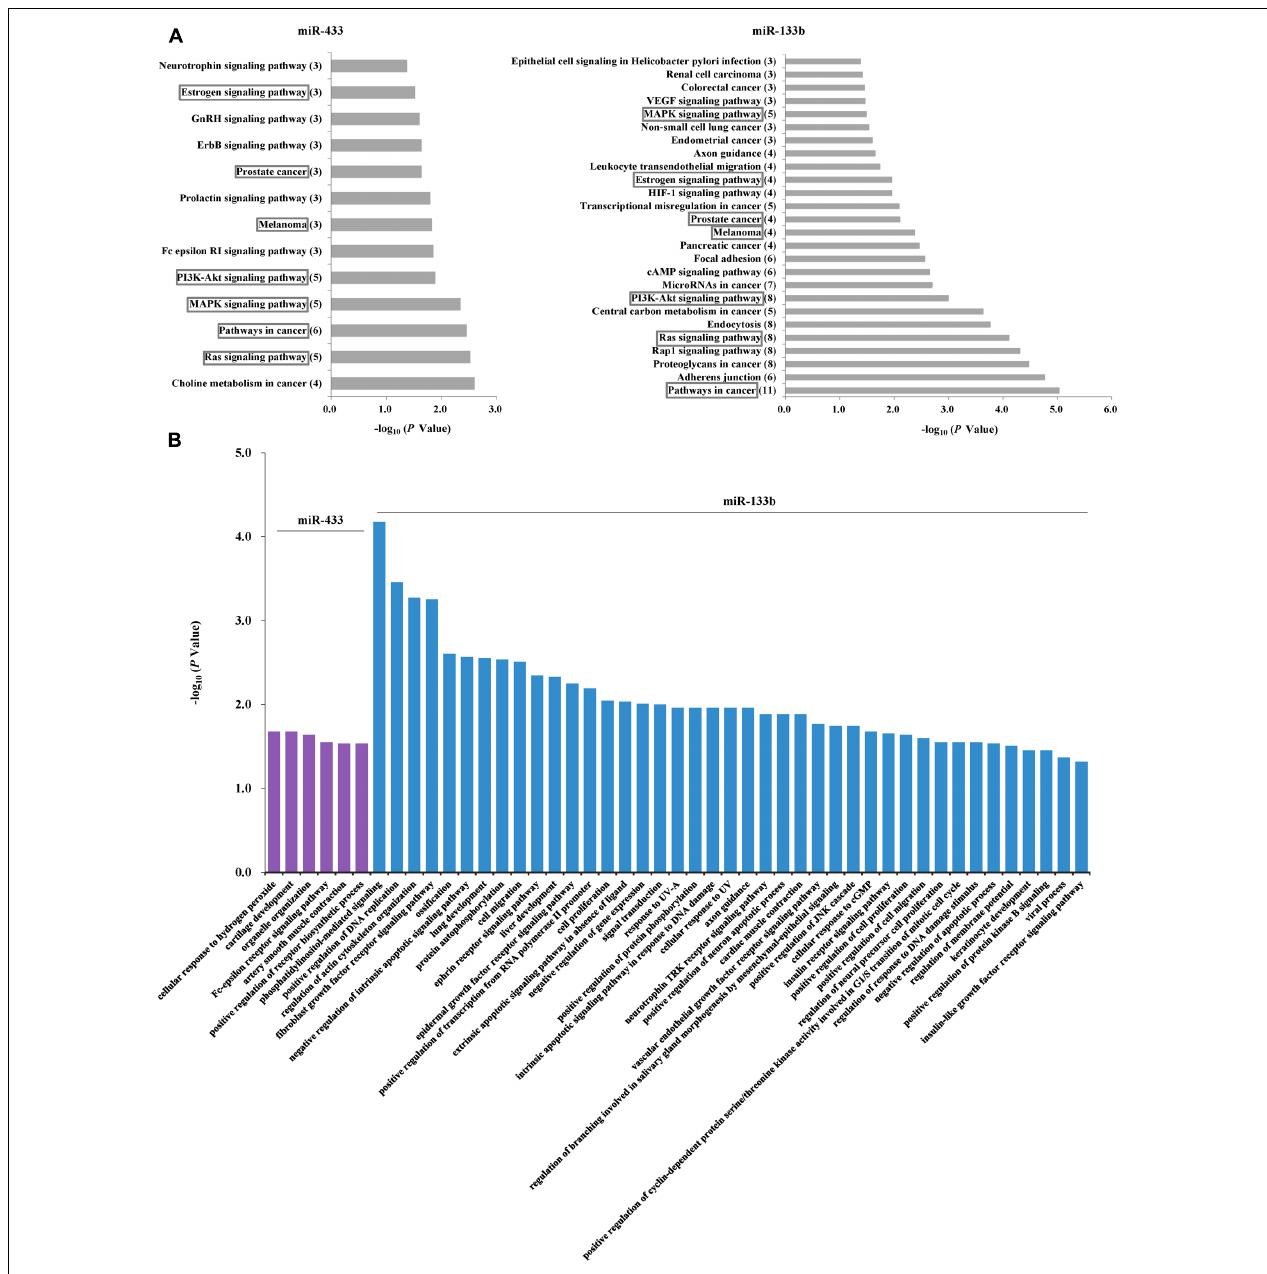
FIGURE 3 | Analyses of potential target genes for miR-433 and miR-133b. (A) KEGG pathway analysis of the target genes. The horizontal axis represents enrichment score. The number of enriched genes for each pathway is shown in parentheses in the vertical axis. The boxes indicate the common pathways shared by miR-433 and miR-133b. (B) Gene ontology analysis of the target genes. P -value was to examine the significance of gene-term enrichment with a modified Fisher’s exact test. Only the pathways or biological processes with P < 0.05 were